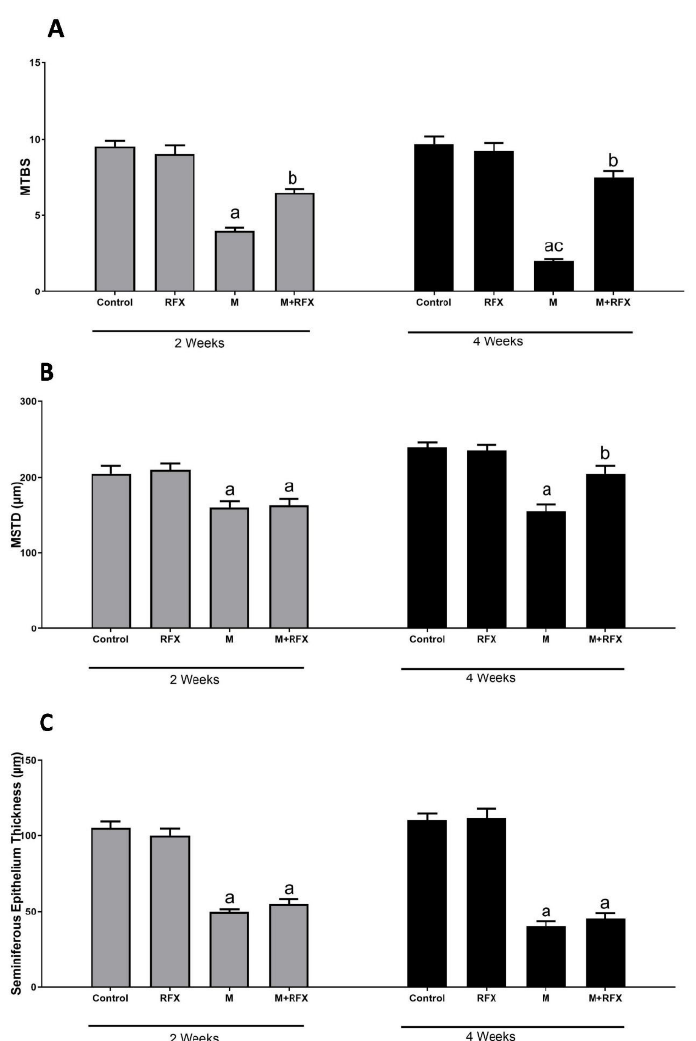
Figure 4. Histomorphometric analysis of the seminiferous tubules. ( A ): Changes in the mean testicular biopsy scores (MTBS) of different groups. ( B ): Changes in the seminiferous tubule diameter (MSTD in µ m) of different experimental groups. ( C ): Changes in the seminiferous epithelium thickness in µ m of different experimental groups. Data are presented as the means ± SEM. a, significant ( p < 0.05) versus control; b, significant ( p < 0.05) versus the malathion group; c, significant ( p < 0.05) versus the two weeks group; data were analyzed with one-way ANOVA followed by Bonferroni-corrected post hoc tests. RFX, rifaximin; M, malathion; M + RFX, malathion and